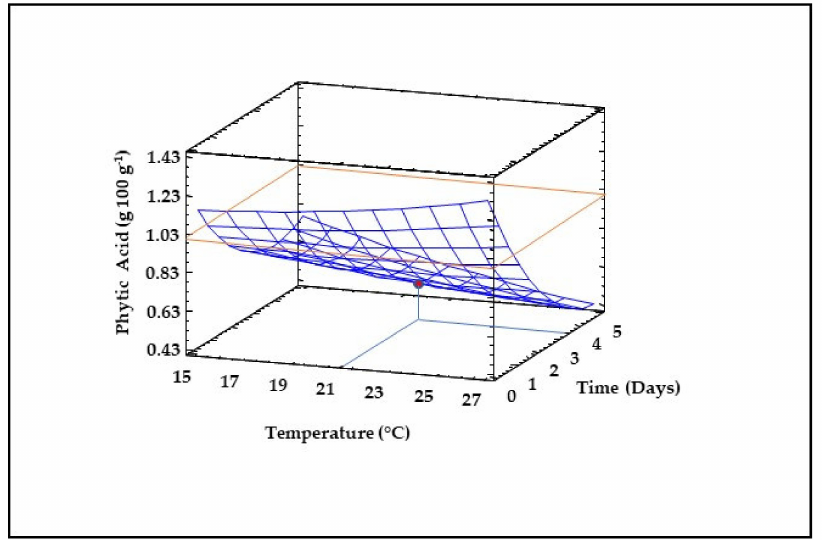
Figure 4. Three-dimensional response surface plots for phytic acid content as a function of the interaction between germination temperature and time. The red line corresponds with the control (ungerminated seed) and the red point with the value for optimum conditions (21 ◦ C and 3.5